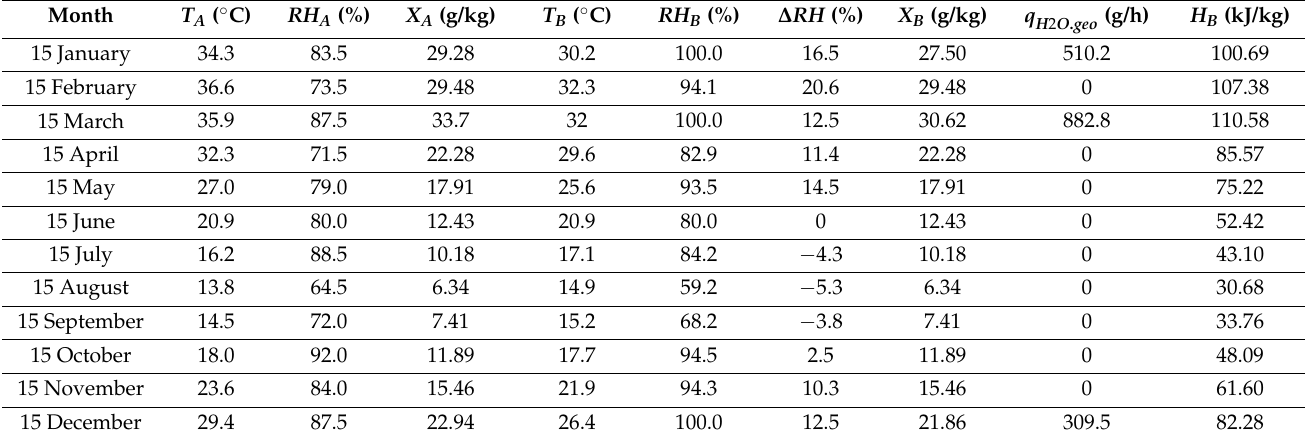
Table 4. Calculation of condensed water in the geothermal system.